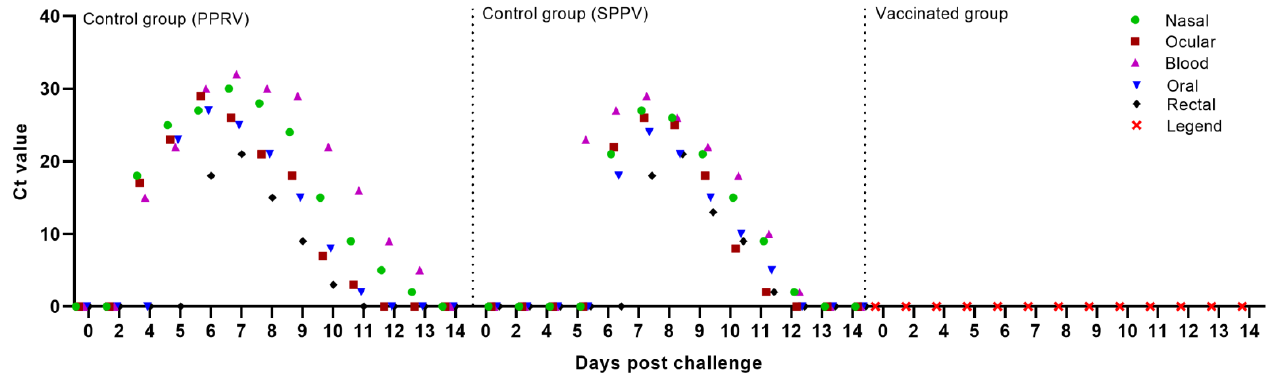
Figure 4. PPRV-specific RNA and SPPV-specific DNA were measured by real-time reverse transcription PCR (RT-qPCR), and the amount of viral RNA and DNA is expressed as a Ct, a value that increases as the amount of viral RNA increases.